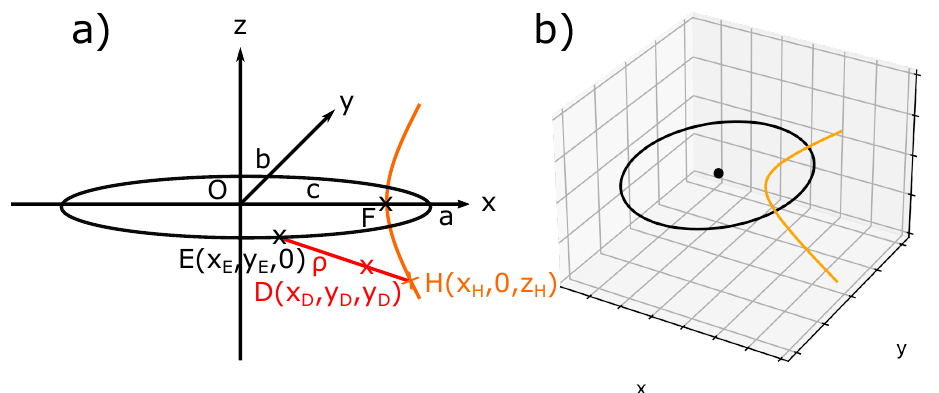
Figure 2. ( a ) Ellipse and hyperbola in a confocal geometry; ( b ) Python simulation of ( a